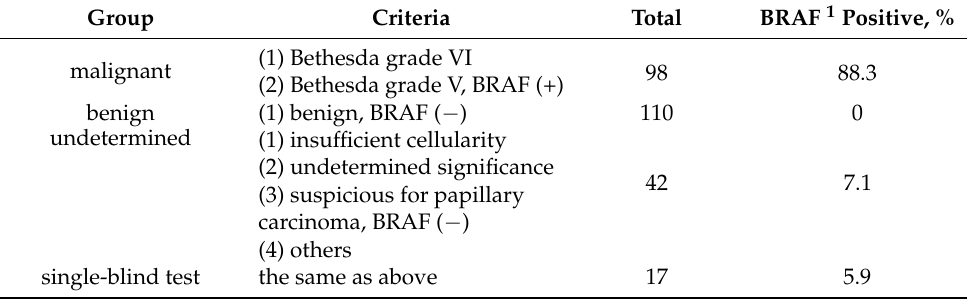
Table 2. The grouping criteria and